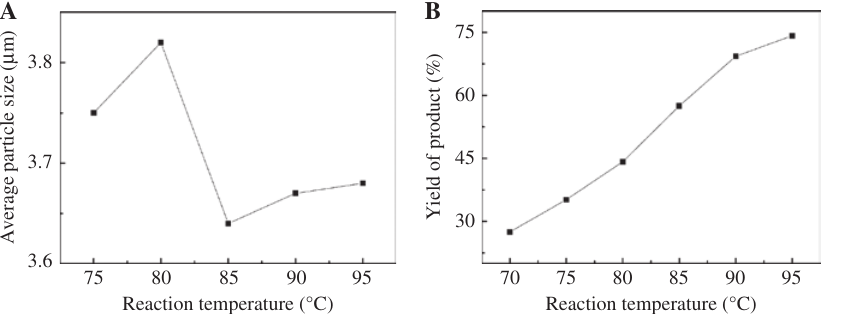
Figure 5: Effect of reaction temperature on average particle size (A) and yield of product (B), respectively, in the homogeneous precipitation.